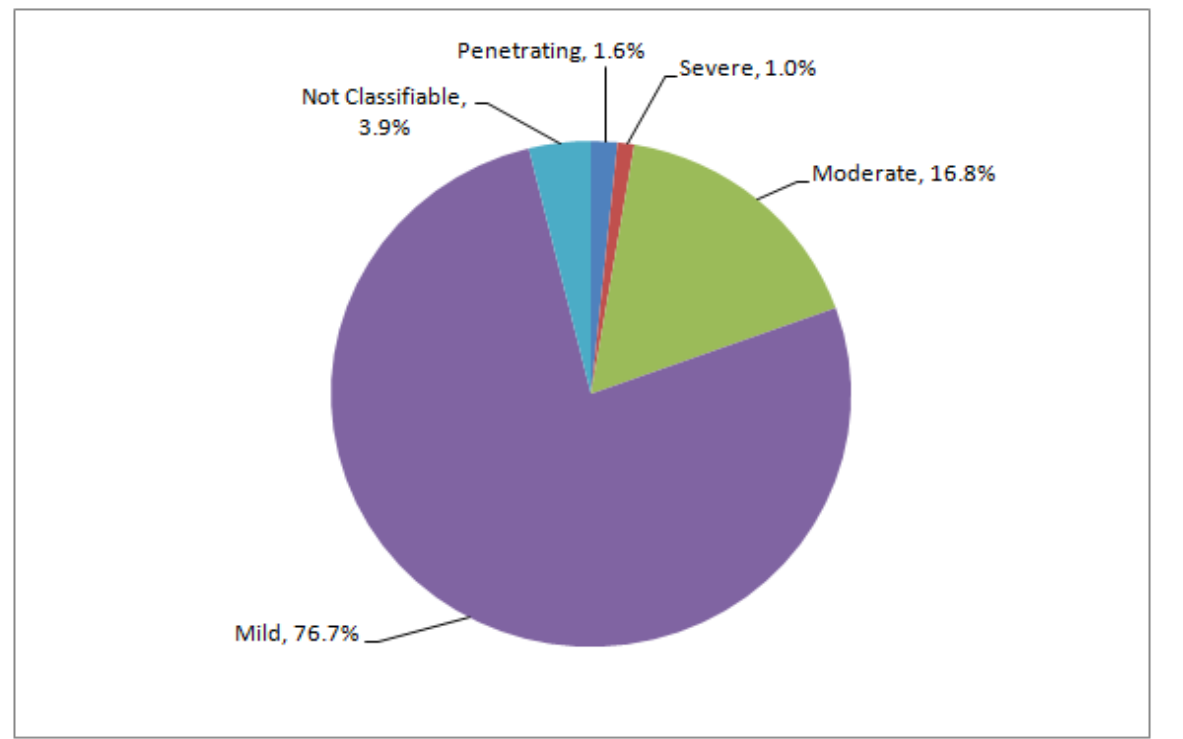
Figure 1. Percentage of U.S. Military Service Members Diagnosed with a TBI, by TBI Severity, 2000-2011